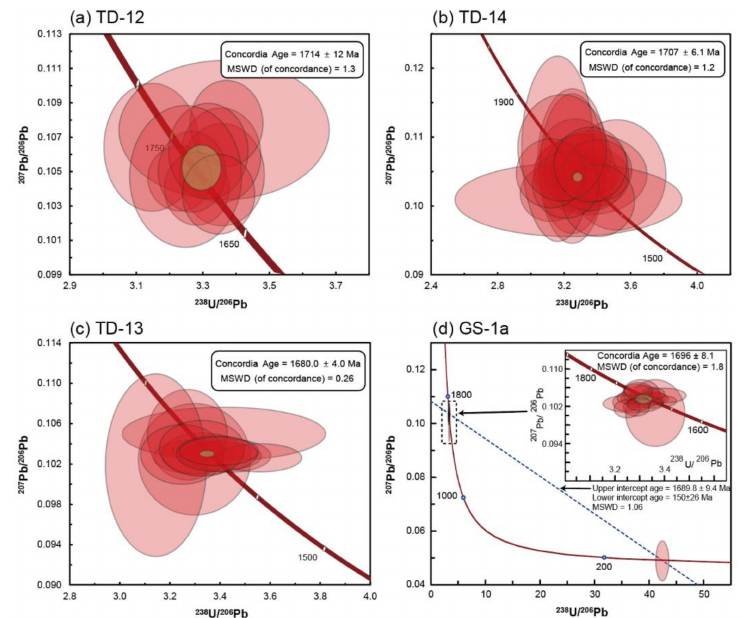
Figure 7. Tera–Wasserburg Concordia diagrams for zircon U-Pb analyses from the AFG ( a , b ) and PAFG ( c , d ).